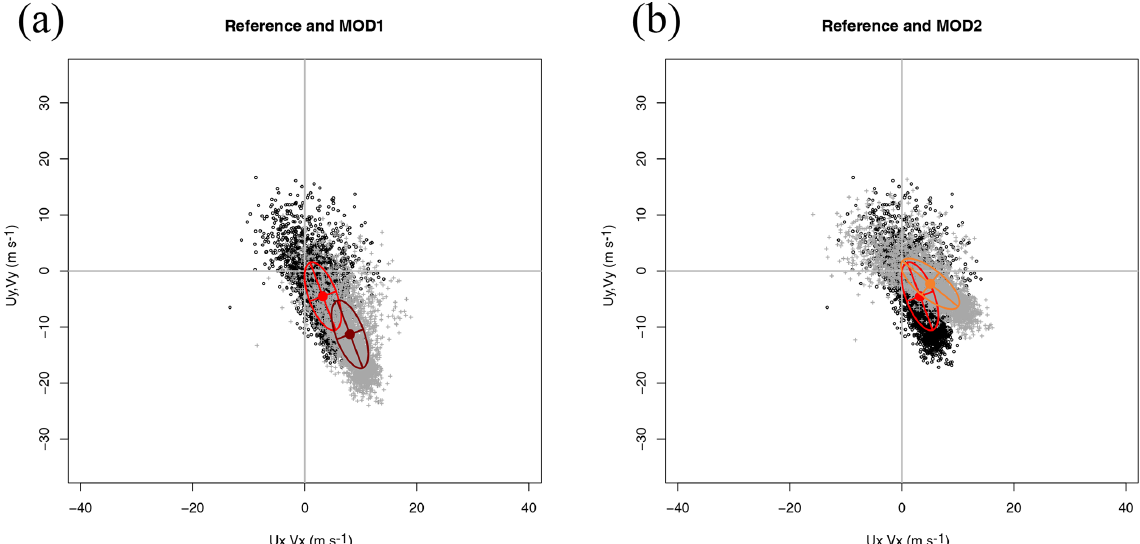
Figure 2. Scatterplot of wind in datasets Ref (panel a , black circles) and MOD1 (panel a , grey crosses) and their decomposition in terms of the principal axes corresponding to the covariance matrix of the zonal and meridional components of each dataset as defined in Eqs. (12) and (15). The comparison of the reference dataset (black circles) with model MOD2 (grey crosses) is shown in panel (b) . (cid:16) (cid:17) V − V R vu representing the model-based V with ˜ V = anomalies rotated to the basis given by the EOFs correspond- ing to